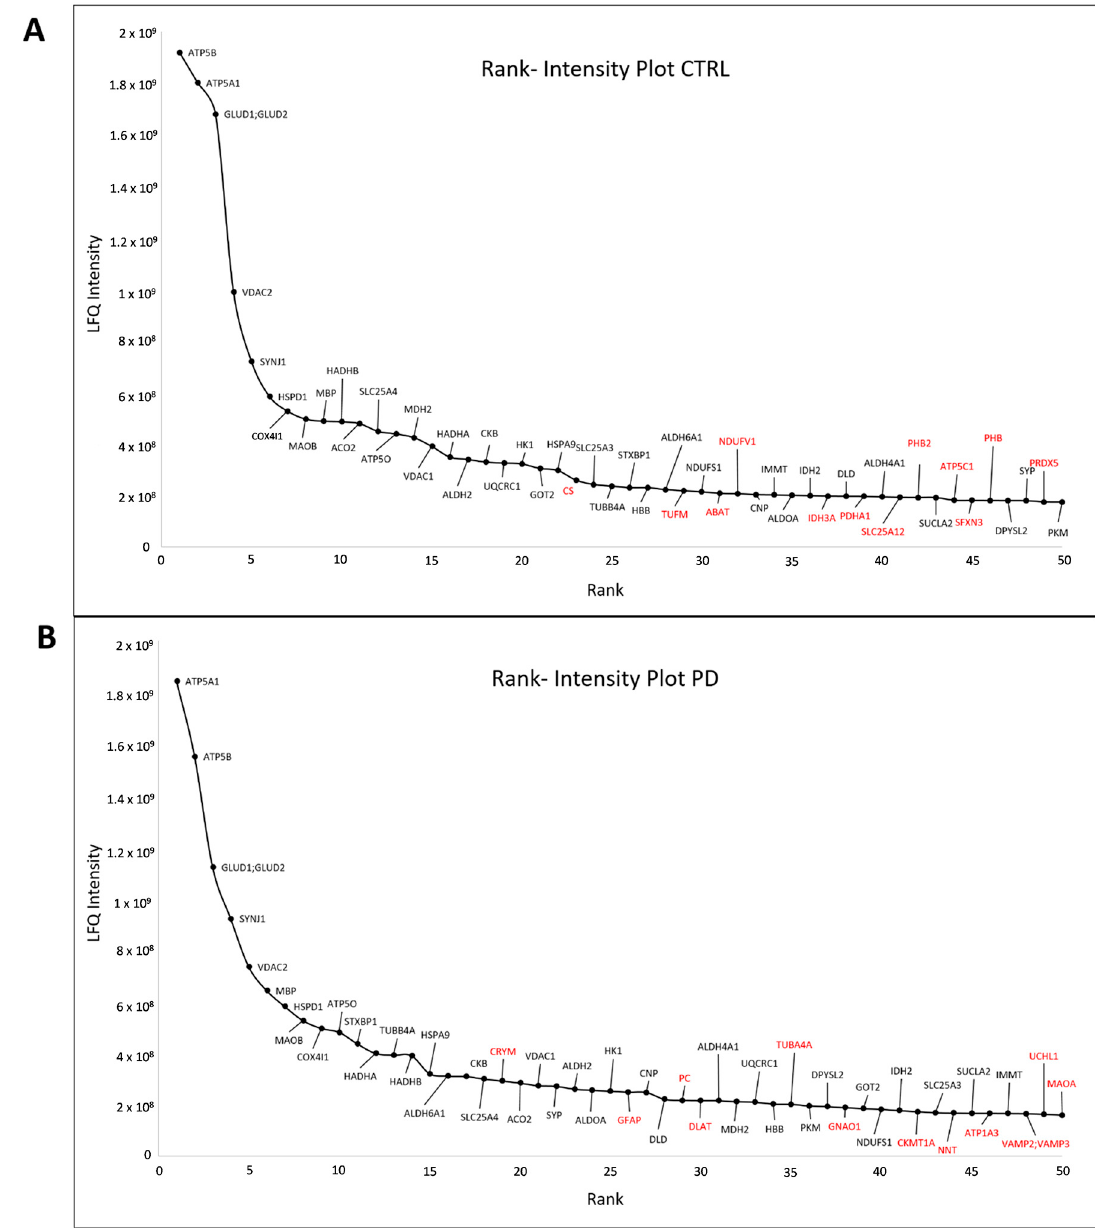
Figure 3. Rank–intensity plot for ( A ) CTRL and ( B ) PD. The mean of LFQ intensities for each protein in each group was calculated. Proteins were subsequently ranked from highest to lowest LFQ intensity. The top 50 proteins were plotted against their intensities. Each protein is marked using the gene name. Proteins being in the top 50 in one group only (either CTRL or PD cases) are marked in